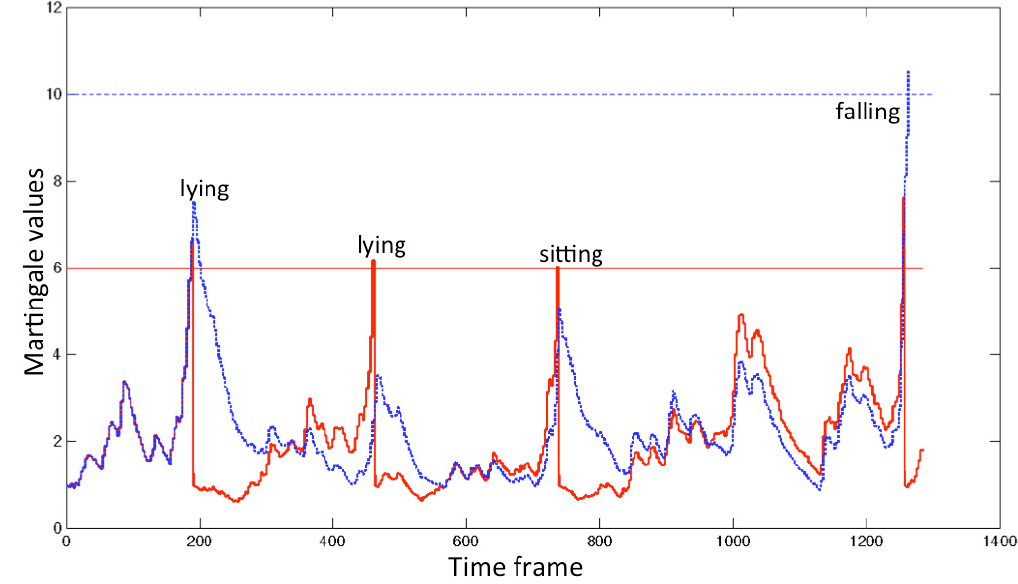
Figure 11. The martingale values when λ is set to 6 (red line) and 10 (blue